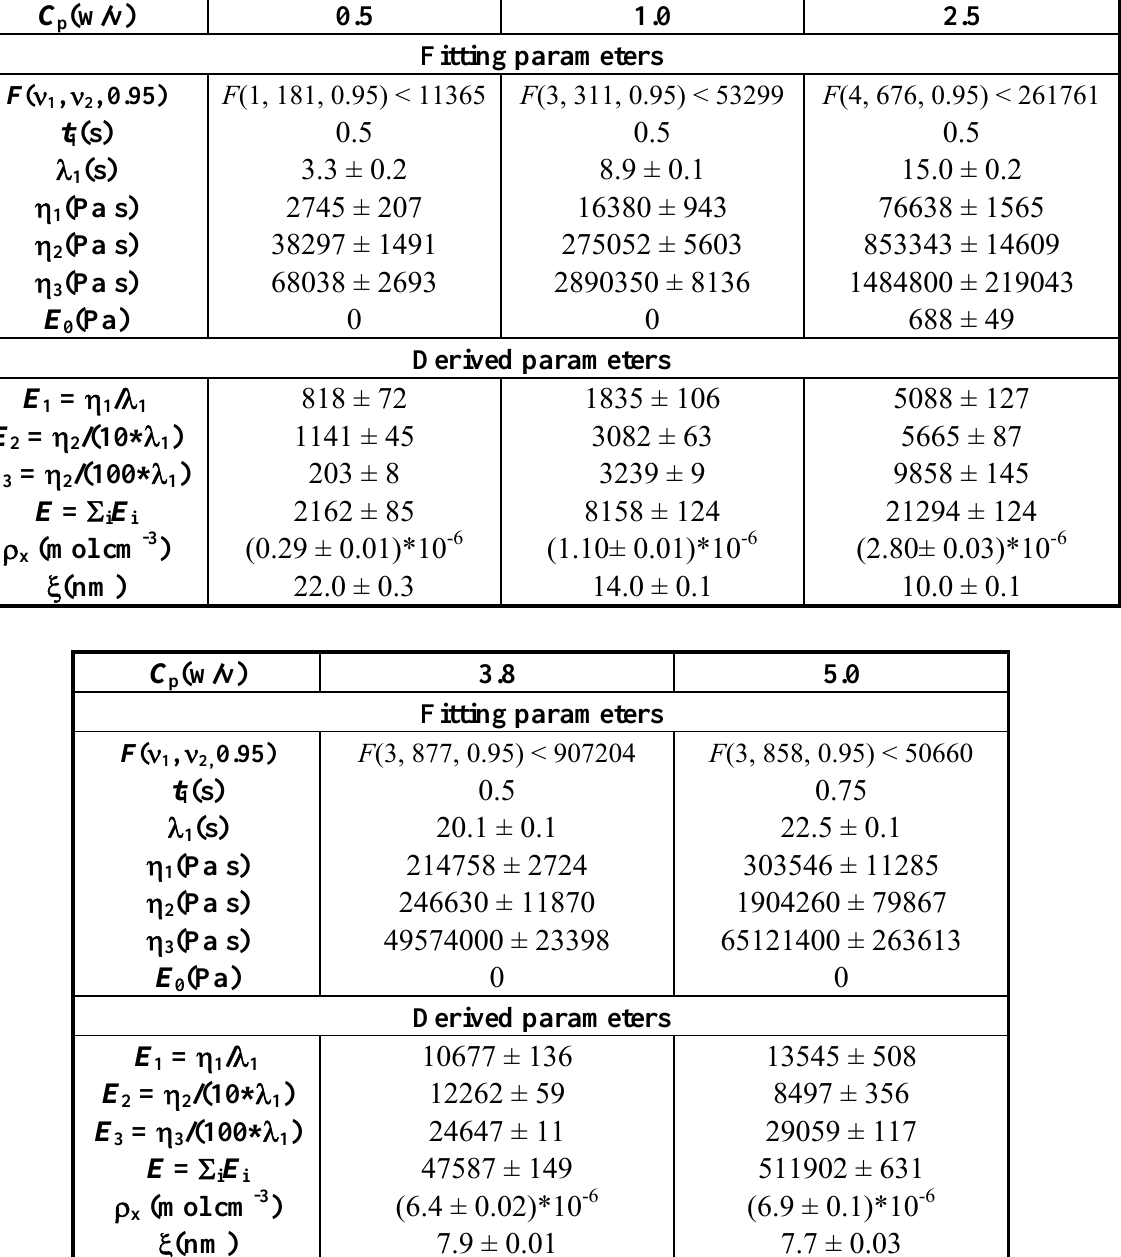
, η , η , η , E ) and derived parameters ( E 1 1 2 3 0 is the time required to get the desired cylindrical 1